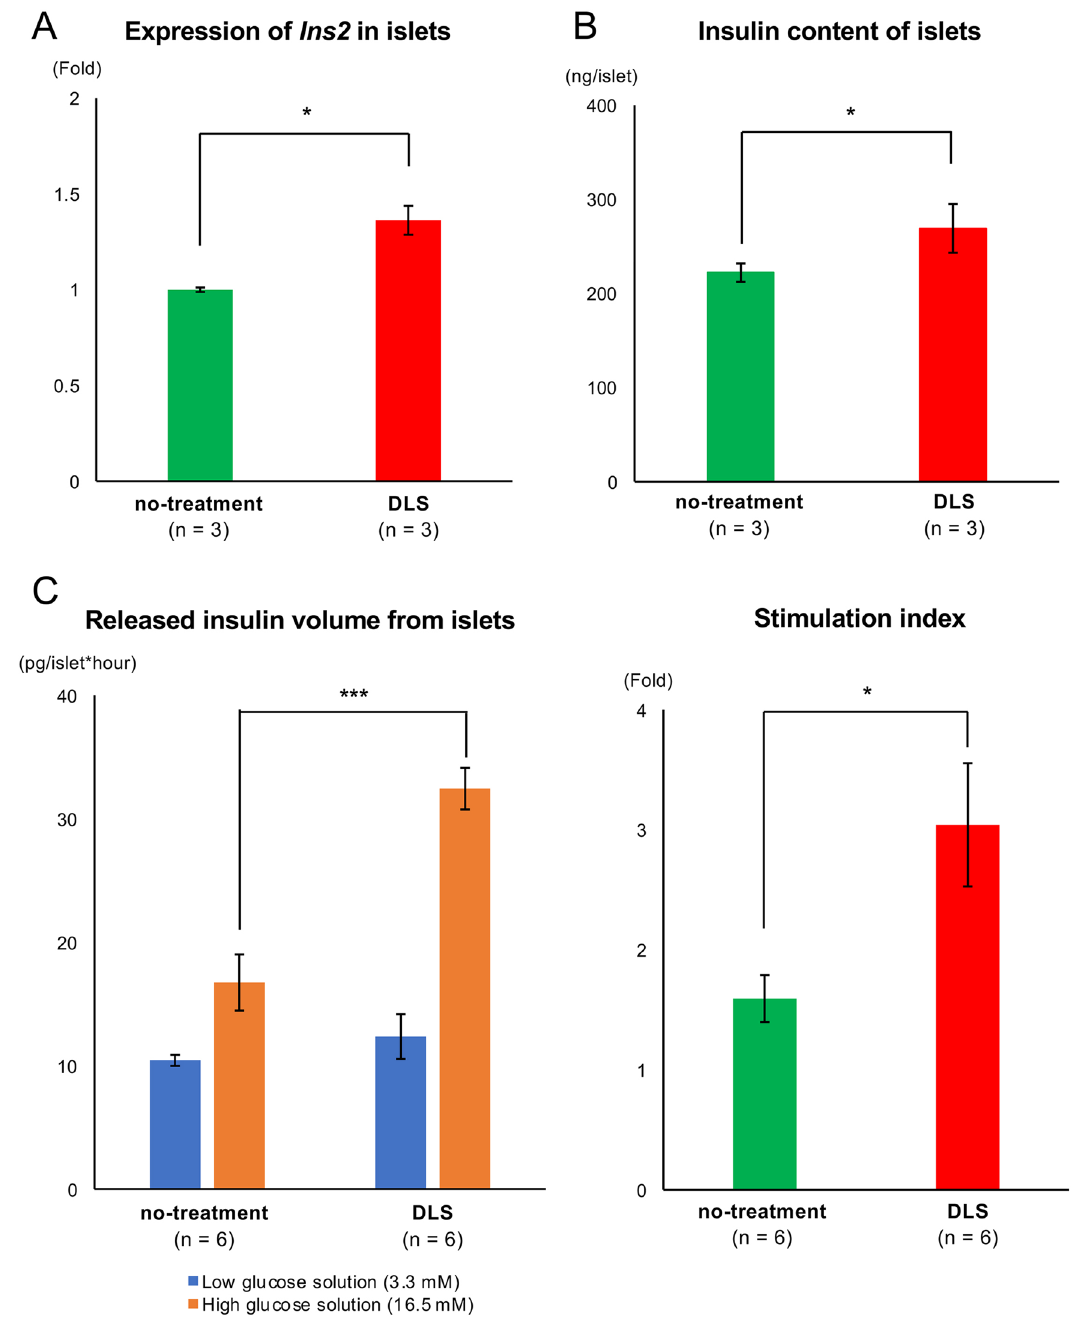
Figure 2. Therapeutic effect of the GHS-R1a antagonist in insulin-releasing function. ( A ) Expression of Ins2 in islets in the no-treatment and DLS groups. Gene expression was quantified using real-time RT-PCR with Actb as the internal control. ( B ) Insulin content of islets in the no-treatment and DLS groups. ( C ) Released insulin volume from islets under low-/high-glucose stimulation ( left ) and stimulation index of islets ( right ) in the no-treatment and DLS groups. Data are presented as means ± SEMs. P value of < 0.05 was considered statistically significant; * p < 0.05, *** p <